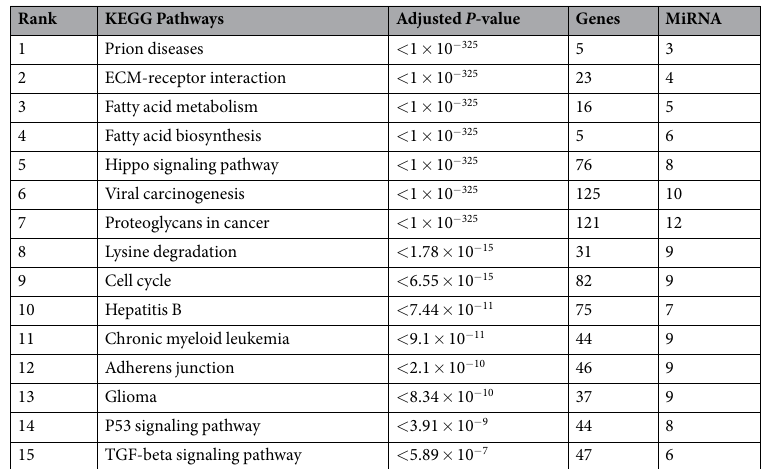
Table 1. KEGG pathways involving the 21 miRNAs altered in abundance in sera of CWD positive elk. KEGG molecular pathways that were enriched with miRNA target genes were identified using DNA Intelligent Analysis (DIANA)-miRPath v3.0 48–51